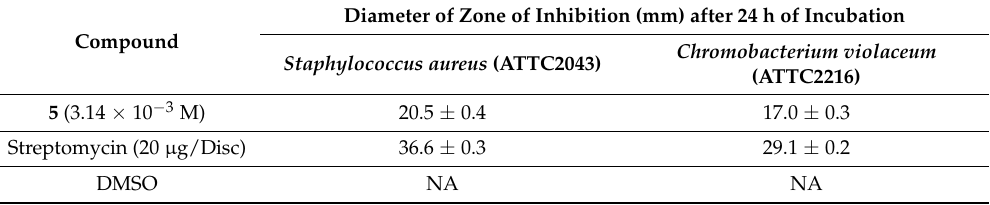
Table 1. Antibacterial activity of compound 5